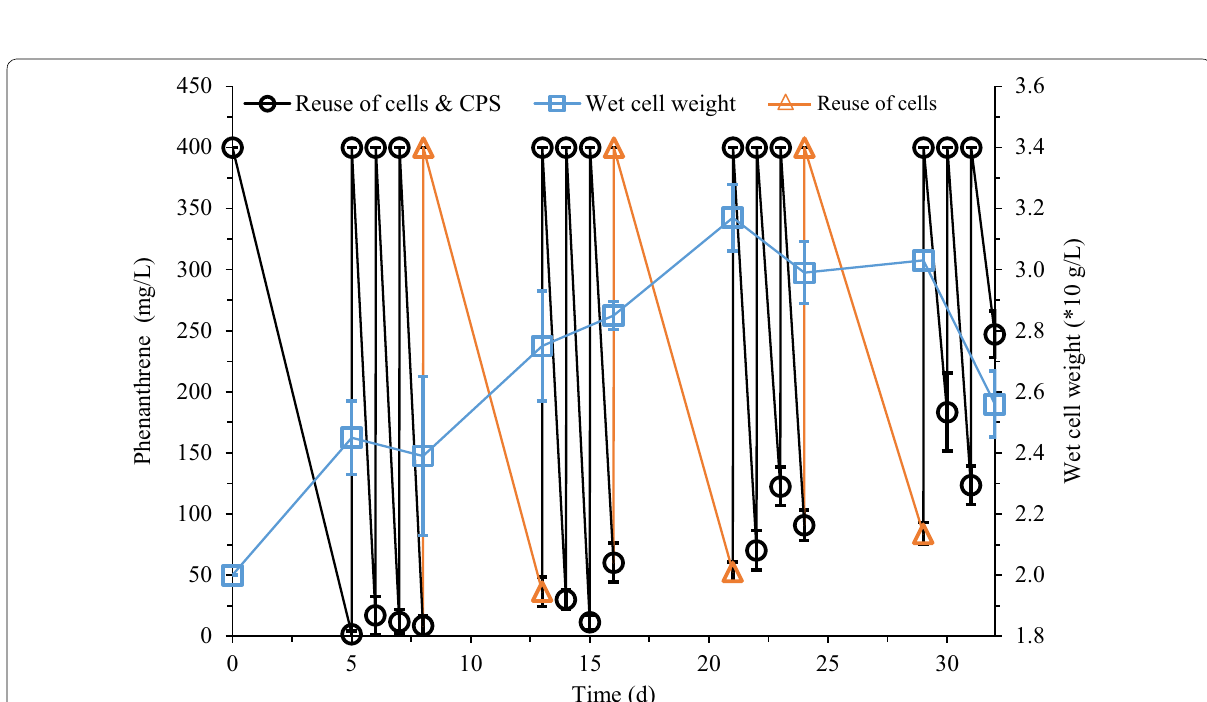
Fig. 6 Combined reuse strategy. S. polyaromaticivorans was inoculated into 30 mL LB medium in a 150-mL flask and cultured at 30 °C and 160 rpm for 18 h. Cells were collected and then inoculated in CPS to degrade phenanthrene for 5 days. Subsequently, a combined recycling